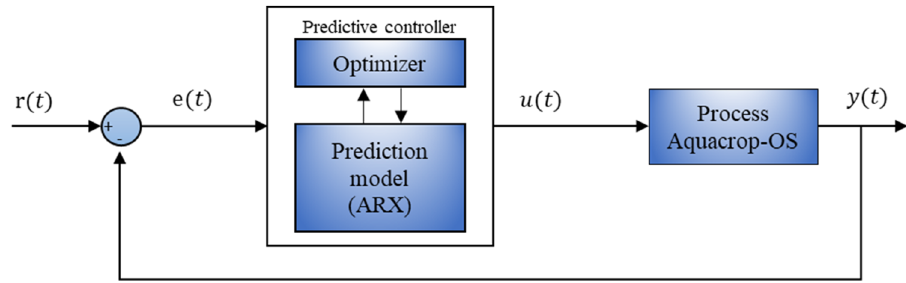
Figure 7: Predictive controller loop implemented in MATLAB.